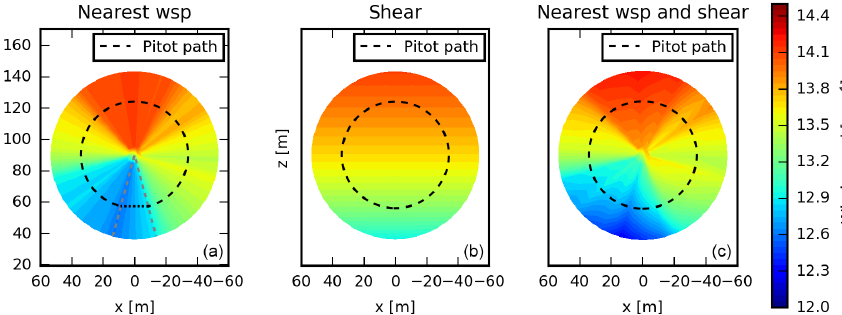
Figure 7. (a) Wind speed based on the nearest pitot-tube wind speed (interpolated values are used in a 30 ◦ sector around the tower to the exclude the effects of tower shadow). (b) Wind speed based on the 1h power shear profile. (c) Wind speed based on the nearest pitot-tube wind speed and power shear